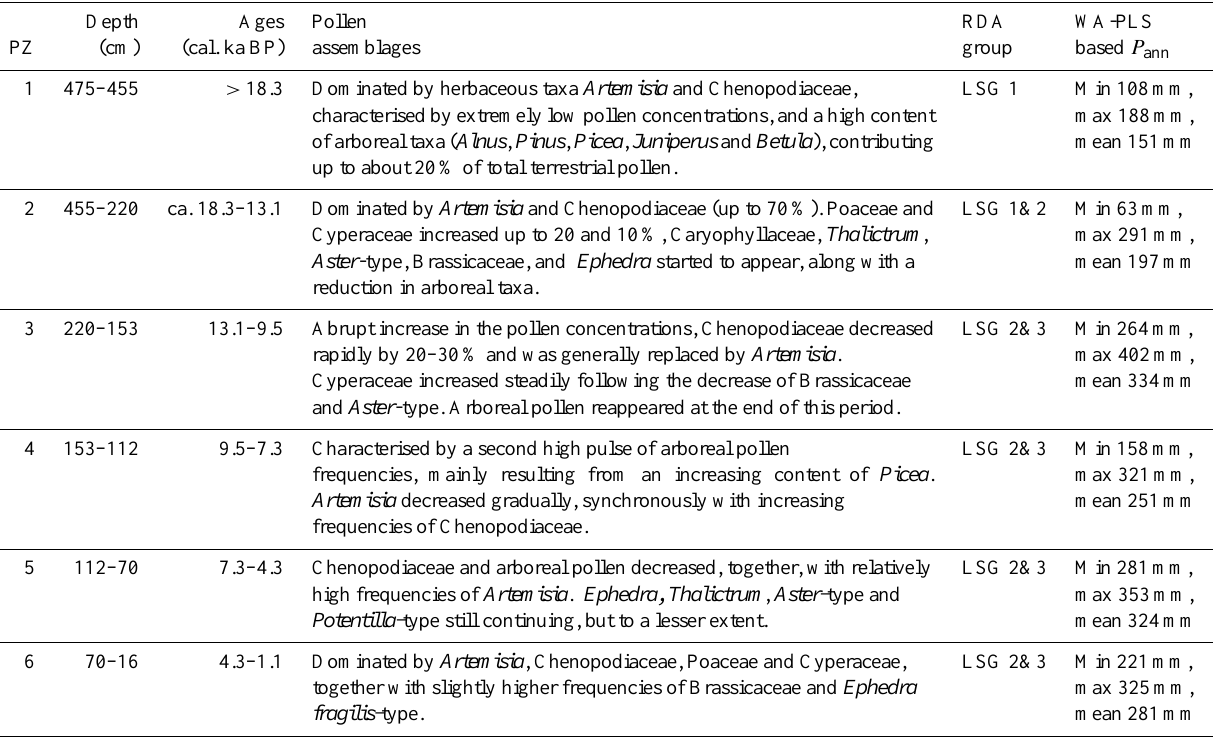
Table 4. Summary of the pollen assemblages and climate reconstructions from Lake Donggi Cona over the last > 18.3cal. ka